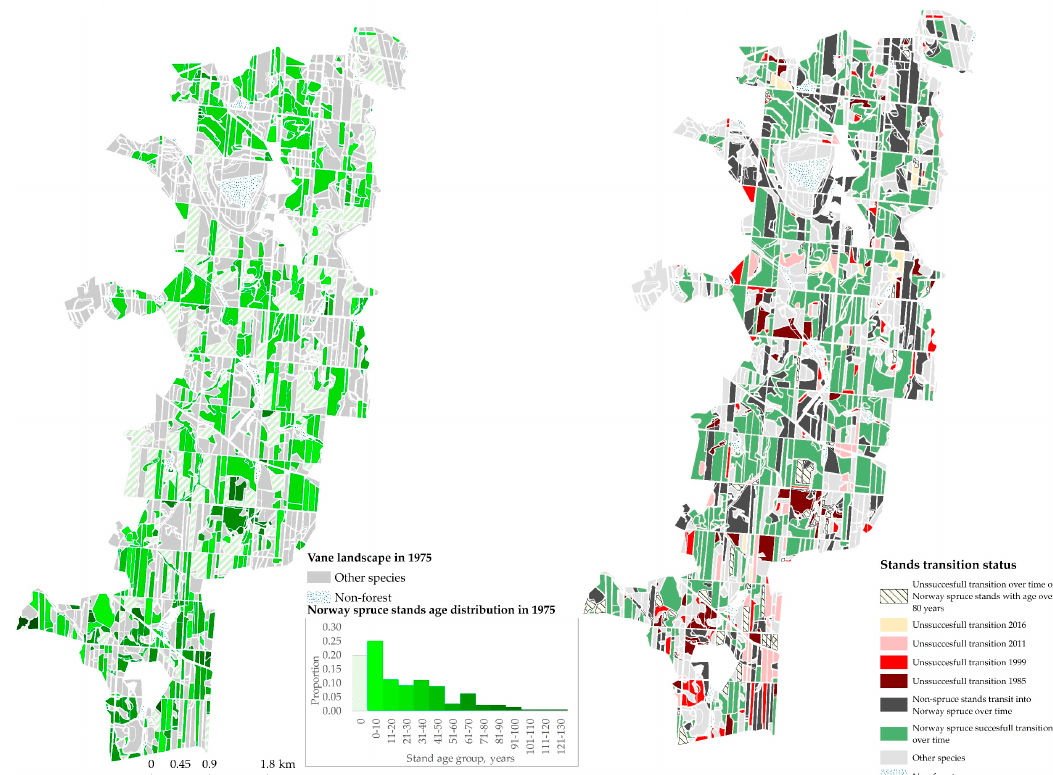
Figure 2. Norway spruce stands dynamics in Vane over 40 years